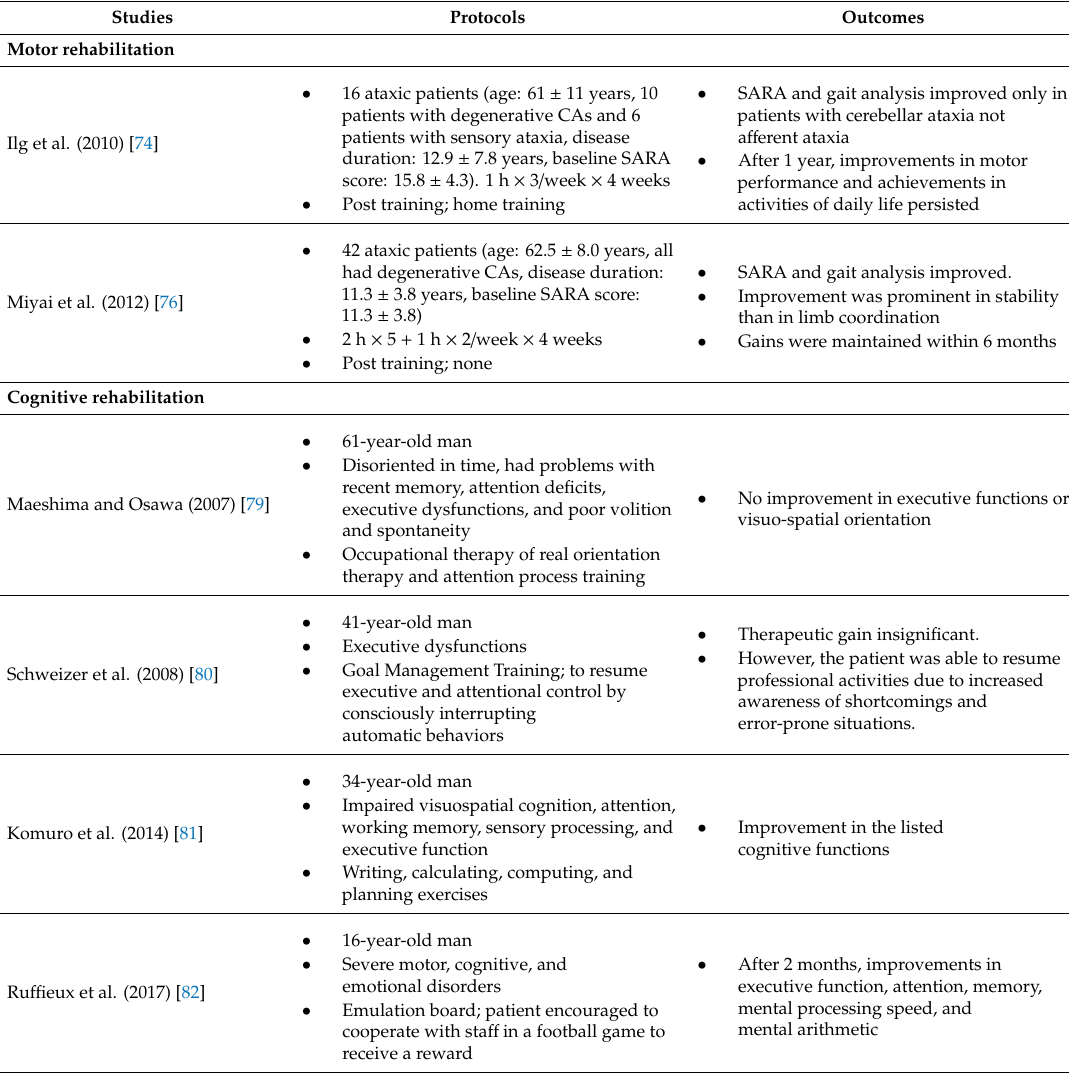
Table 3. Protocols and outcomes of